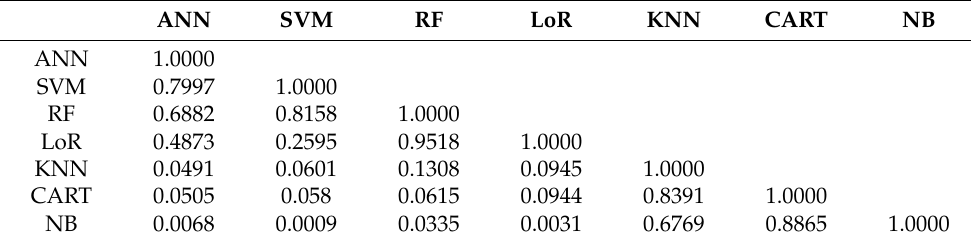
Table 3. Comparison of ROC values between different machine learning models for smoking cessation.